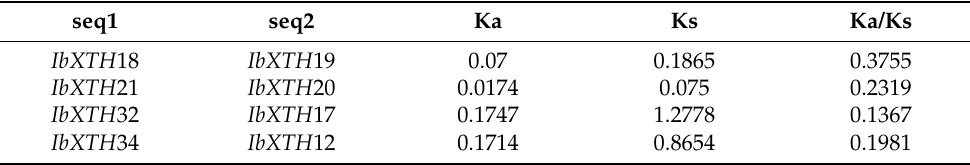
Table 2. The Ka/Ks analysis of XTH homologous gene pair in sweet